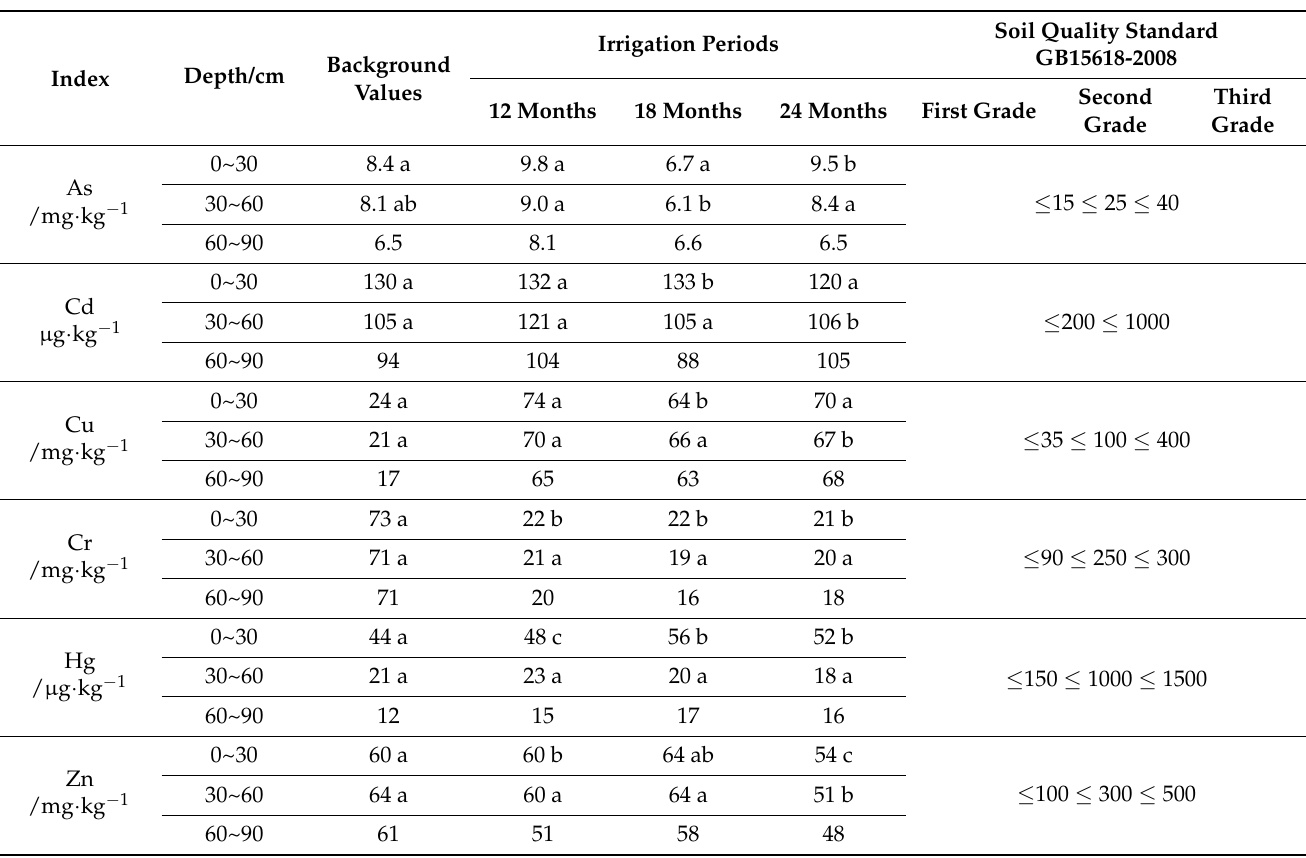
Table 2. Soil heavy metal contents for different unconventional water in different irrigation periods and background